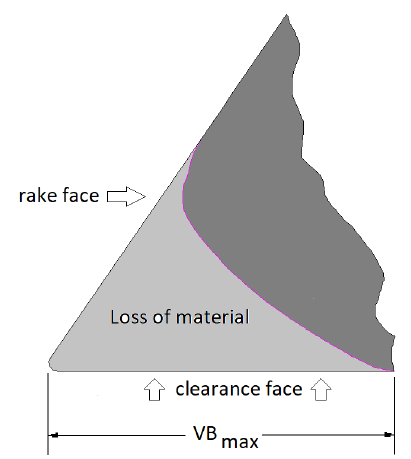
Figure 5. Schematic illustration VB max .